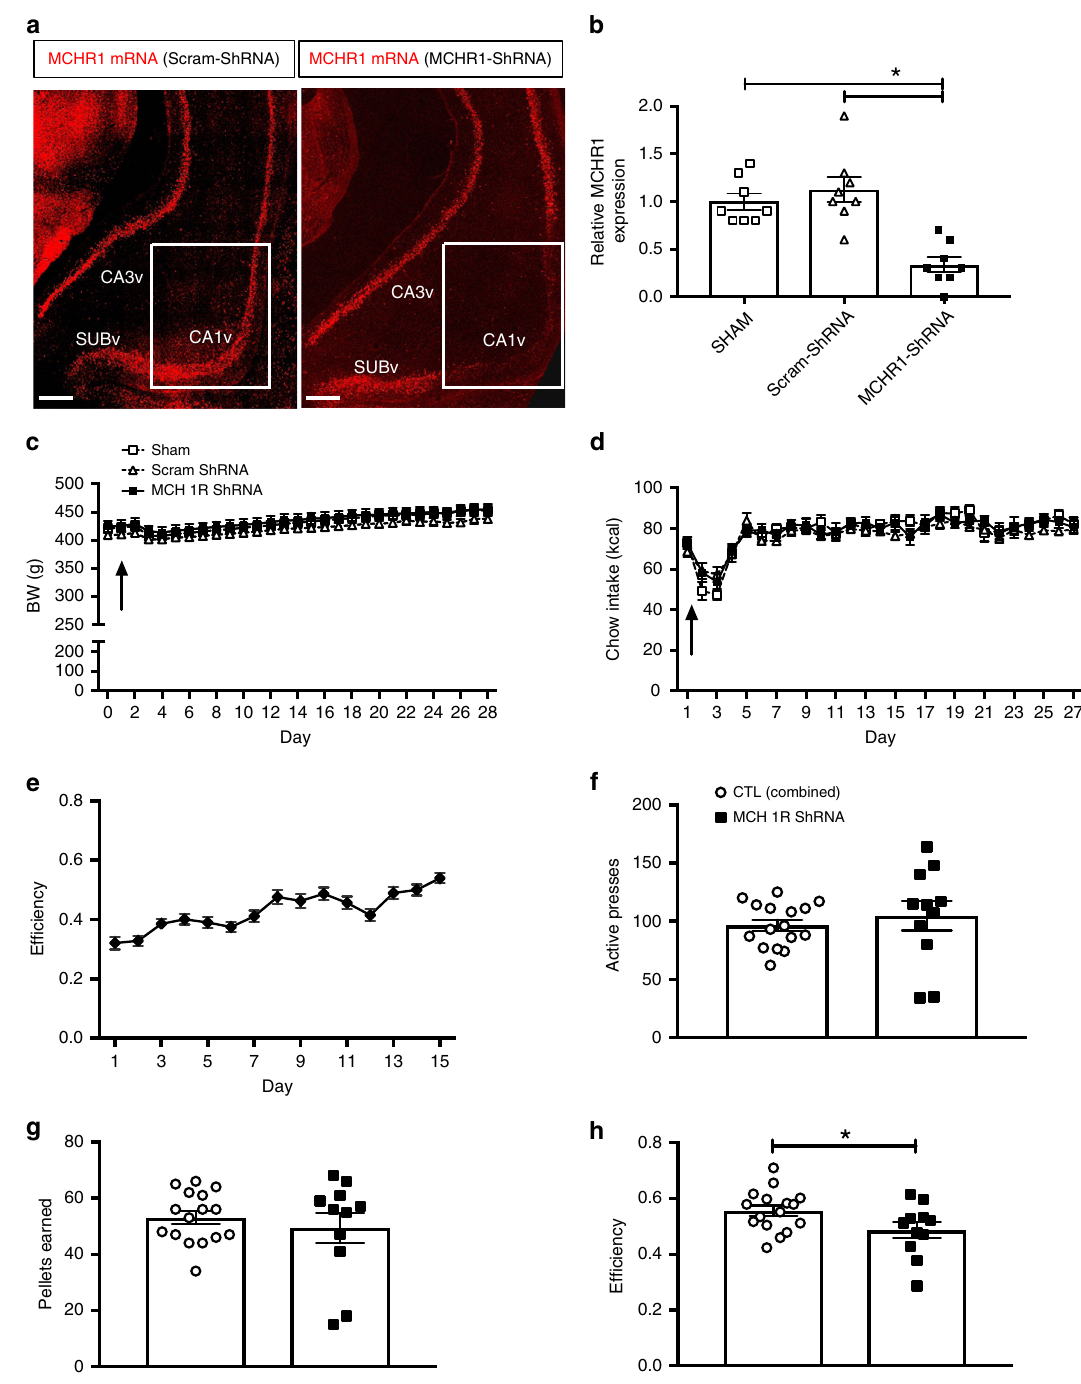
Fig. 5 MCHR1 knockdown increases food impulsivity. a Representative images showing MCHR1 gene expression via fl uorescence in situ hybridization and b relative MCHR1 gene expression (relative to Sham controls) via qPCR in CA1v in scrambled control shRNA (Scram-shRNA) or MCHR1 shRNA injected animals (one-way ANOVA with Tukey ’ s multiple comparisons test; n = 8/group; P < 0.05); scale = 200 µ m. c Body weight and d chow intake before (day 0) and after surgery in animals injected with either Scram-shRNA ( n = 8), MCHR1 shRNA ( n = 11), or Sham injected ( n = 8); arrow indicates surgery date. e Ef fi ciency data during the training phase in DRL 20 (before RNAi AAV injections). f – h ; Student ’ s two-tailed, unpaired t test; n = 11, 16 (combined controls) f Number of active lever presses, g number of pellets earned and h ef fi ciency in the DRL task following RNAi AAV incubation ( P = 0.04). Data shown as mean ± SEM; * P < 0.05. Source data are provided as a source data fi